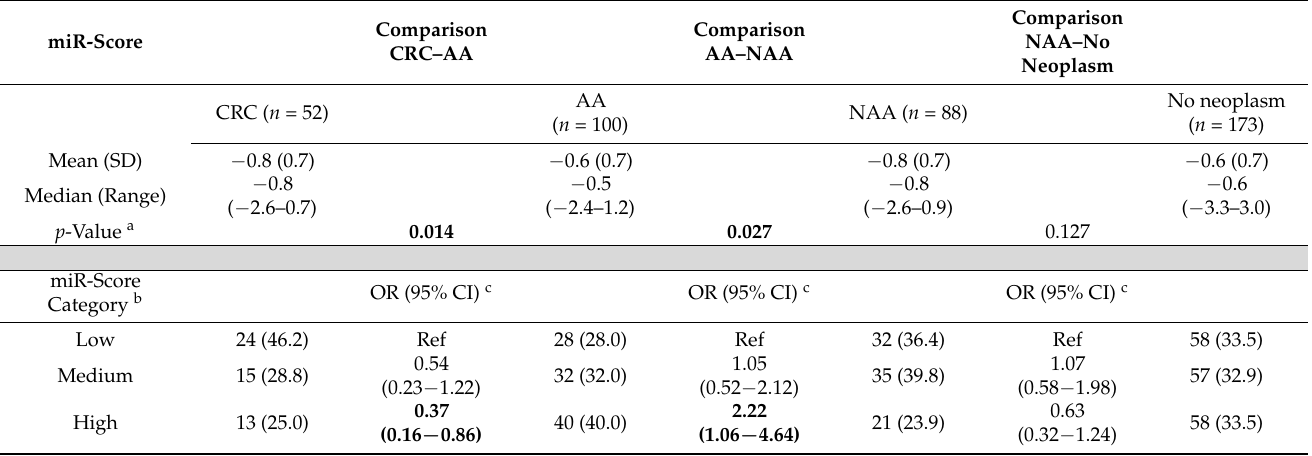
Table 2. Comparison of miR-Score Distributions Between Groups with Various Findings